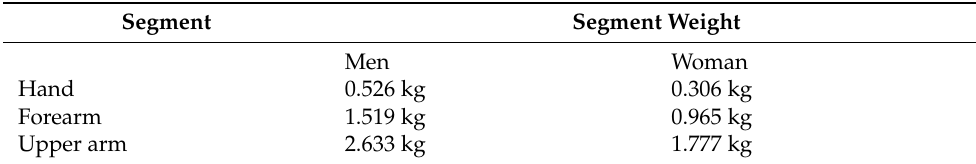
Table 2. Weight of upper-limb segment according to Plagenhoef [39].